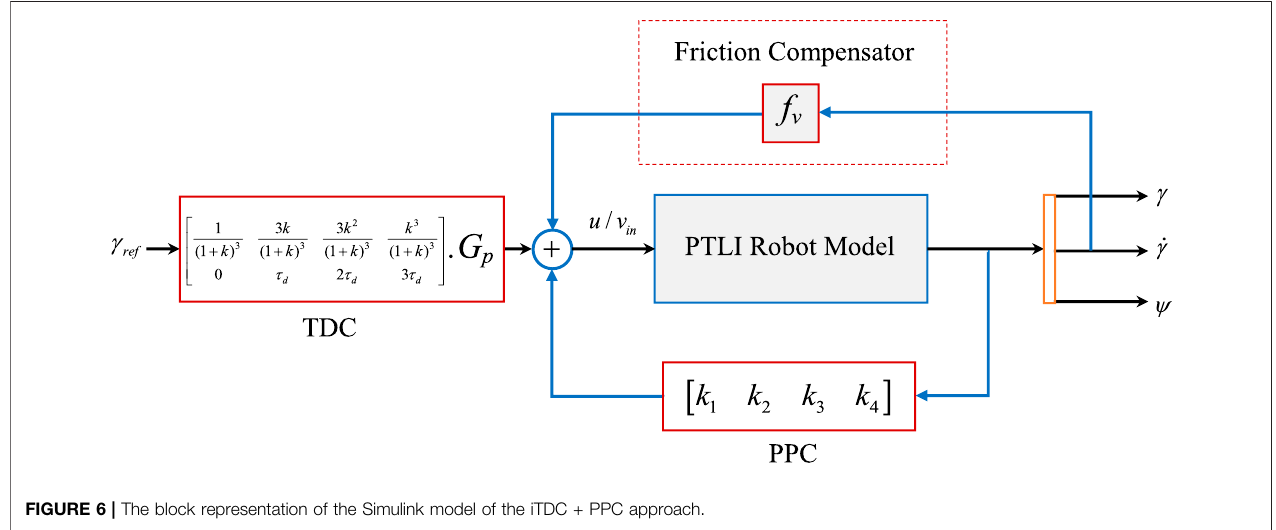
FIGURE 6 | The block representation of the Simulink model of the iTDC + PPC